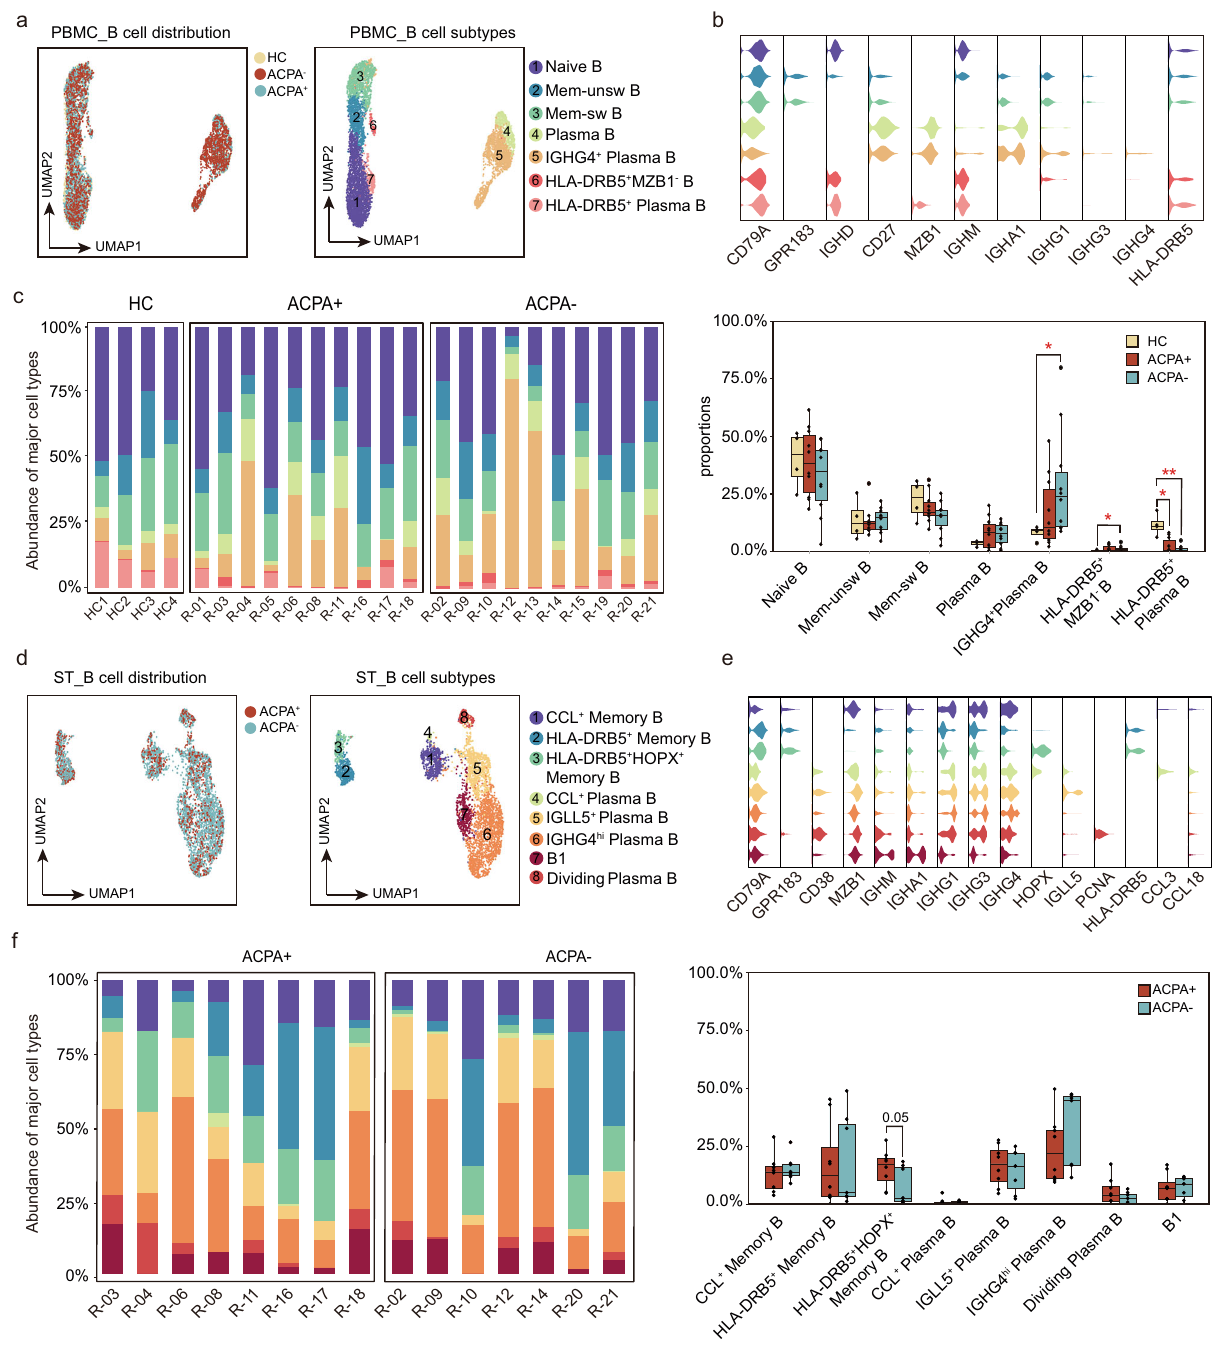
Fig. 2 Lack of HLA-DRB5 expression by B cells from patients with ACPA- RA. a UMAP visualization of B cell subsets from PBMC. We identi fi ed 7 B cell clusters across 6152 cells. Cells are marked by ACPA type (left) and cell subtype (right). b Violin plots showing marker genes across PBMC B cell subtypes. The y axis represents log-scaled normalized counts. c Left: bar plots showing the relative percentage of PBMC B cell subtypes for each sample as in a. Right: box plots showing the proportions of each PBMC B cell subtypes across ACPA groups. Cell types showed enrichment in ACPA + or ACPA- subgroups are marked with * P values were calculated by the two-sided Wilcoxon test. * p < 0.05 (from left to right, p = 0.024,0.036,0.013), ** p < 0.01 ( p = 0.0058). n = 4 for HC, n = 10 for ACPA + group, and n = 10 for ACPA- group. d UMAP visualization of B cell subsets from STMC. We identi fi ed 8 B cell clusters across 4151 cells. Cells are marked by ACPA type (left) and cell subtype (right). e Violin plots showing marker genes across STMC B cell subtypes. The y axis represents log-scaled normalized counts. f Left: bar plots showing the relative percentage of STMC B cell subtypes for each sample as in d . Right: box plots showing the proportions of STMC each B cell subtypes across ACPA groups. Cell types showed enrichment in ACPA + or ACPA- subgroups are marked. P values were calculated by the two-sided Wilcoxon test. n = 10 for ACPA + group, and n = 10 for ACPA-